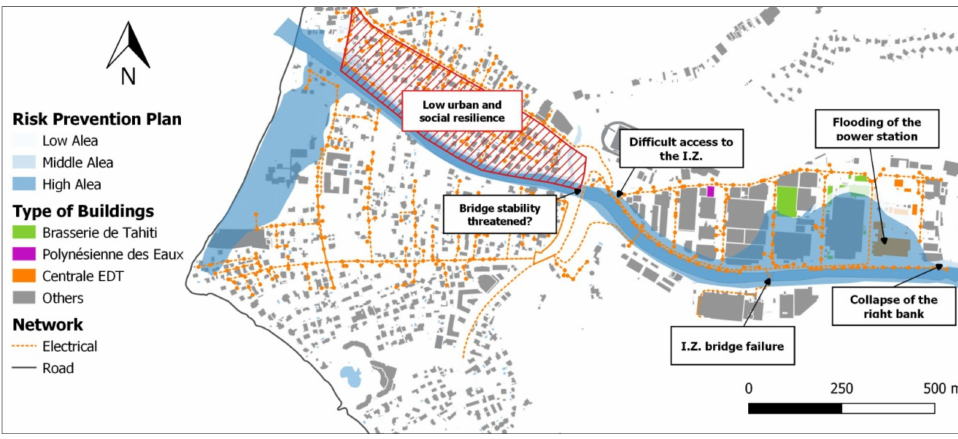
Figure 6. Spatialization of the flood risk and its associated risks in the Punaruu